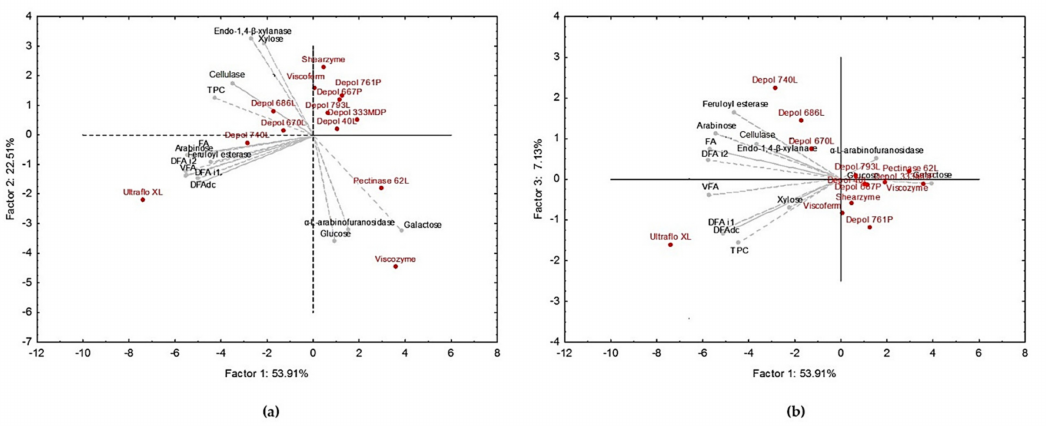
Figure 1. Bi-plots of principal component analysis (PCA): Factor 1 vs. Factor 2 ( a ) and Factor 1 vs. Factor 3 ( b ) separates enzymatic treatments in terms of enzymatic activity profile, phenolic acids, and monosaccharide composition of WB hydrolysates. Abbreviations: decarboxylated form of dihydroferulic acid (DFA dc); dihydroferulic acid isomer 1 (DFA i1); dihydroferulic acid isomer 2 (DFA i2); ferulic acid (FA); total phenolic compounds (TPC); vanillin ferulic acid (VFA).